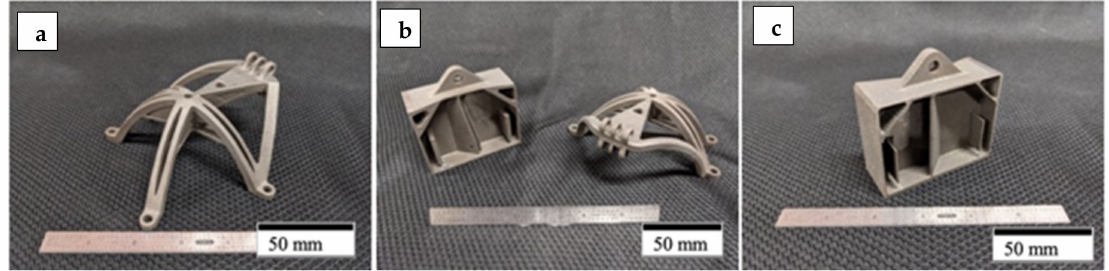
Figure 4. Annealed parts successfully printed from Ti64 HDH. ( a ) Topologically optimized bracket. ( b ) Side to side printed geometries. ( c ) Electronics box enclosure.